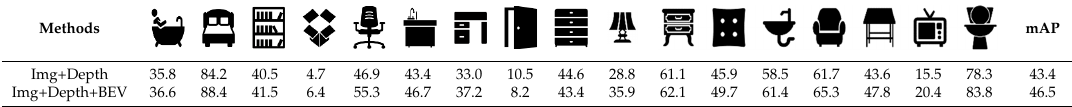
Ours Table 3. 3D object detection comparisons on the SUN RGB-D dataset (mAP: mean average precision). Methods